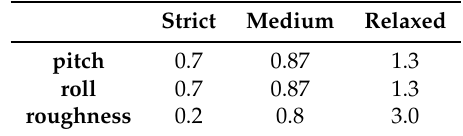
Table 1. Set of boundaries for RRT ∗ expansion.